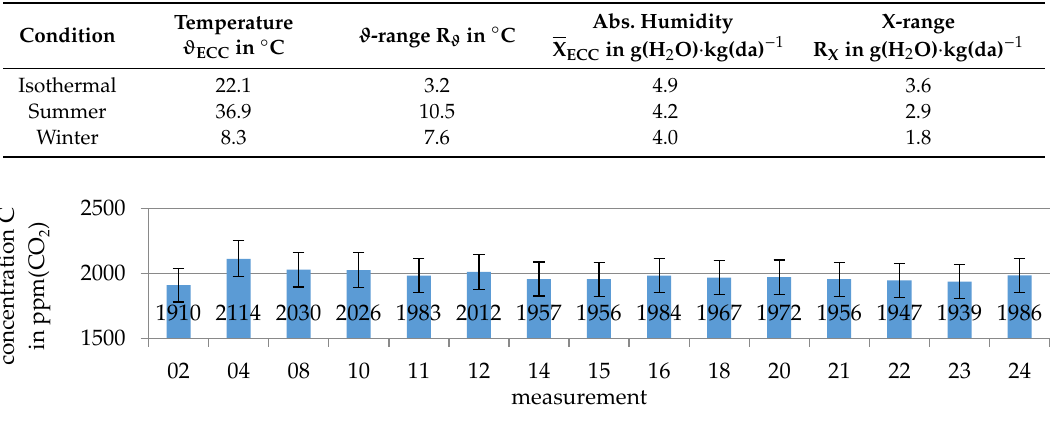
Figure 3. Initial concentrations including simple uncertainty error bars These relatively low initial concentration levels are chosen based on the lowest upper measurement limit (2000 ppm) of the sensors available for the campaign. ISO 16000-8 recommends an initial concentration of 100 ⋅ detection limit, which would be equal to ≈ 5000 ppm [15]. To homogenise the accumulating CO 2 circulation fans have been placed in the ICC, which can be switched off remotely without entering the ICC. For the injection of the CO 2 into the ICC a hose connected to a pressurised gas cylinder outside the ICC has been used. During the homogenisation the outside apertures of the push-pull devices are blocked by cardboard caps. The devices are then switched on during the homogenisation. The initialisation of the decay measurement is the removal of the cardboard caps. Sensors at max(N) = 17 positions shown in Figure 4 and summarized in Table 6 record the discharging behaviour of the employed tracer gas.